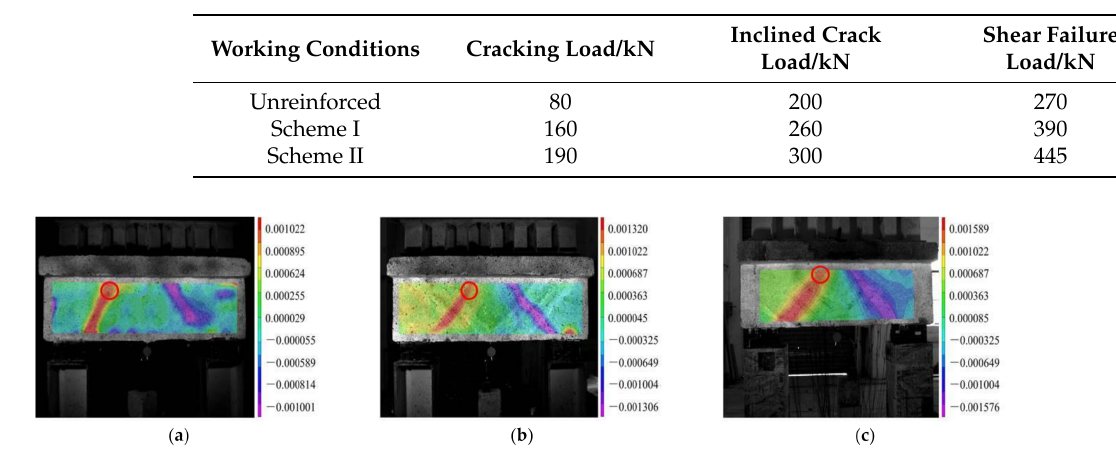
Table 9. Experimental average of three level loads on the three working conditions.